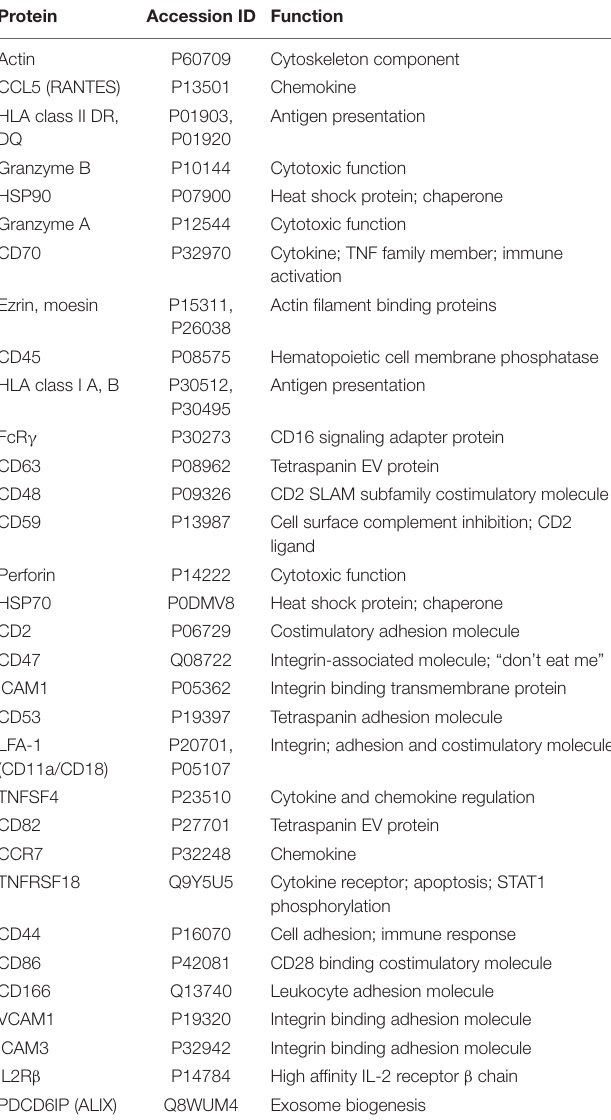
TABLE 2 | List of abundant miRNAs in NK3.3-derived EVs.